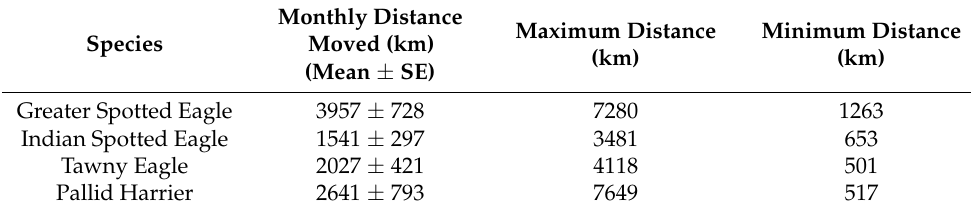
Table 3. Monthly average distance travelled during migration and non-migration months by four rap- tor species. The monthly distance indices presented here were estimated using Tracking Analyst Tools in ArcGIS 10.8.1. Minimum and maximum distances correspond to the months during which raptors were non-migratory and the maximum distance corresponds to the months of active migration.